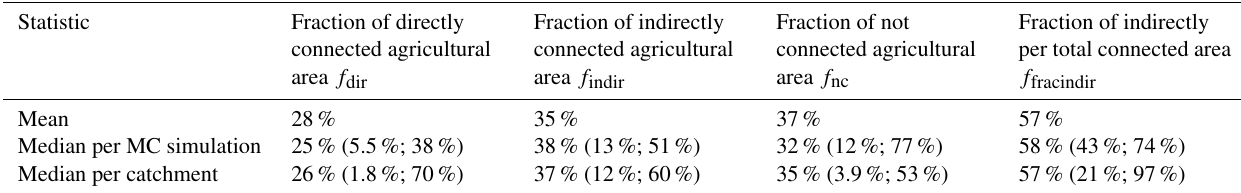
Table 6. Fractions of directly, indirectly, and not connected agricultural areas in our study catchments. The first row represents the mean fraction over all catchments and Monte Carlo simulations. The second row represents the median of the median over all catchments per MC simulation. The third row represents the median of the median over all MC analyses per catchment. In parentheses, the minimum and the maximum median are given.